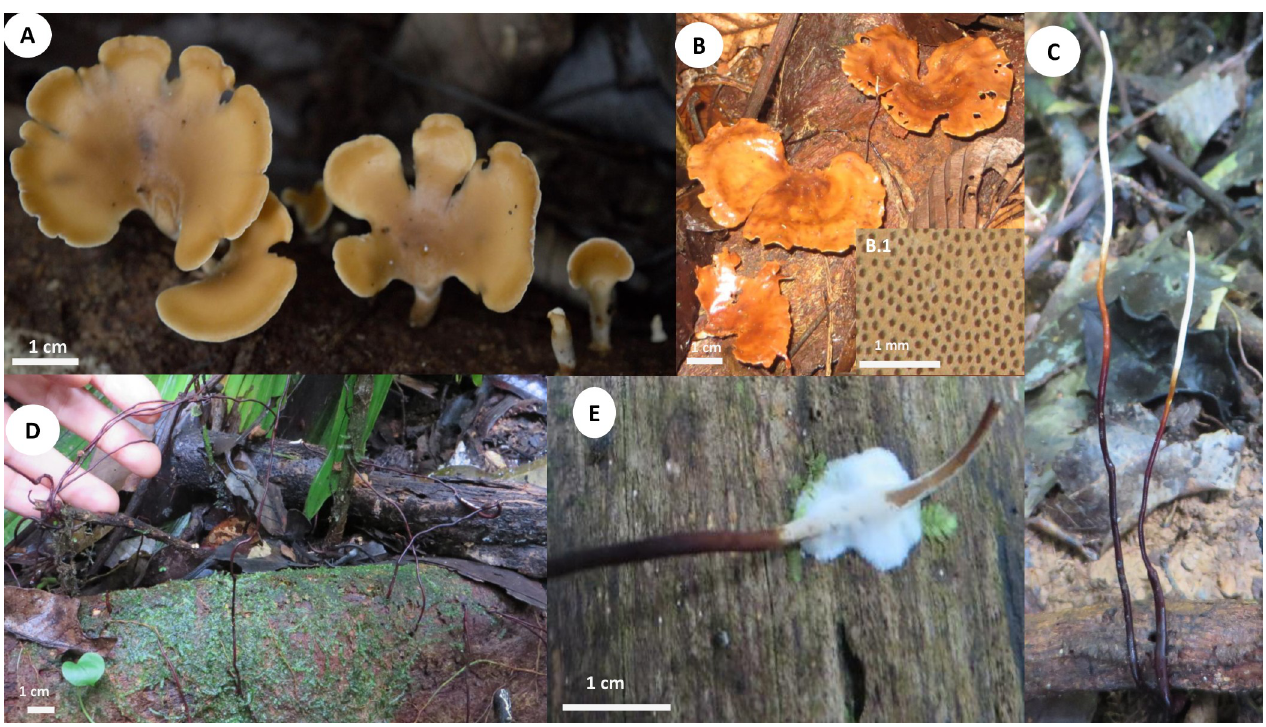
Fig 11. Basidiomata and rhizomorphs of Polyporus leprieurii var. yasuniensis . A. Gregarious habit of basidiomata and primordia. B. Aged basidiomata. B.1. Pore layer. C. Freshly developed rhizomorphs D. Aged rhizomorphs emerging from coarse-woody debris. E. White rhizomorphic mat formed on new wood